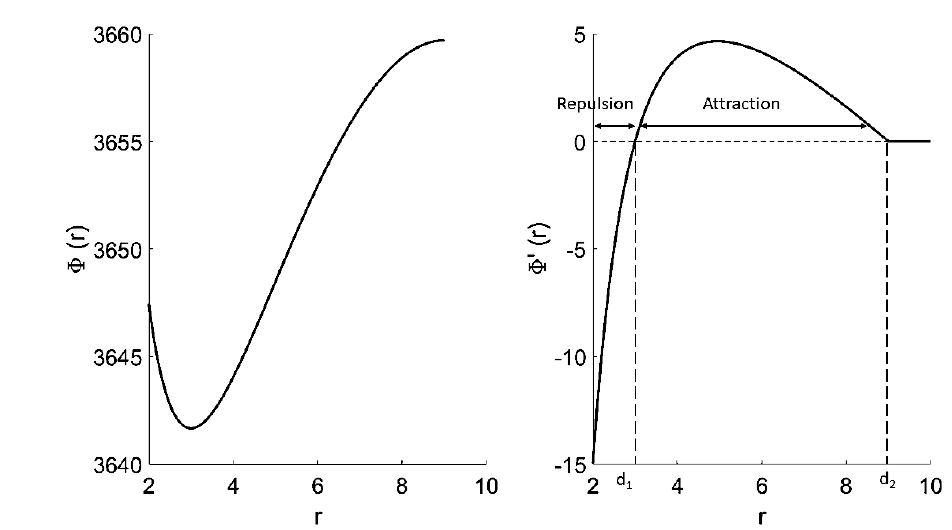
Fig. 3. Left: the potential Φ( r ) (13b) for d 1 = 3 , d 2 = 9 . Right: the corresponding potential force Φ (cid:48) ( r ) with a cut-off for r > d 2